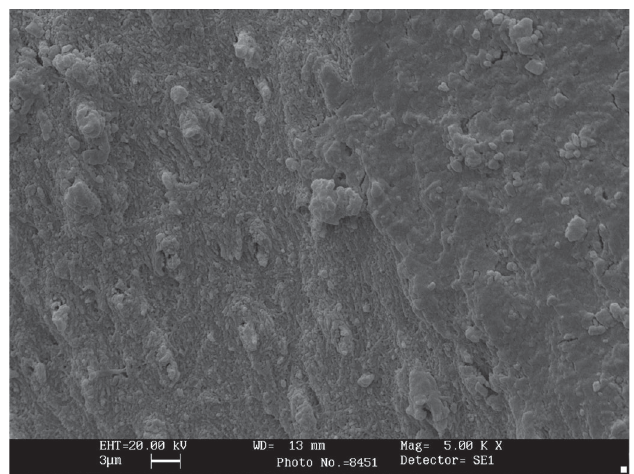
Fig. 2 - SEM image of the Sca group showing the presence of debris, no residual calculus, irregular root surface and smear layer and smear plug covering all root dentin.